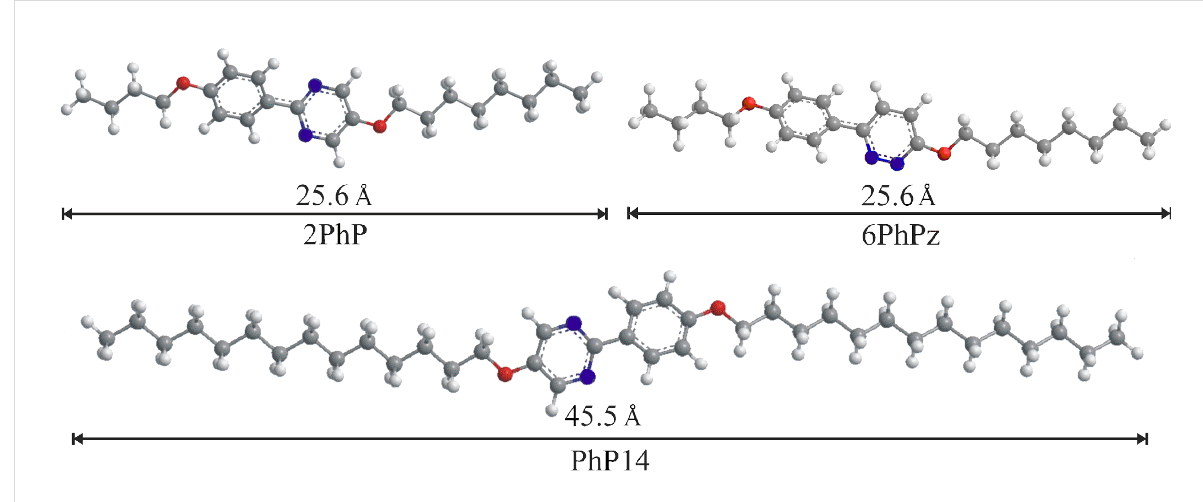
Figure 2: Molecular structure of the mesogens PhP14 , 6PhPz and 2PhP differing in molecular lengths by a factor of approximately two. The molecular lengths were determined from the most extended conformers, after optimizing their energy using molecular modelling with MOPAC/AM1.